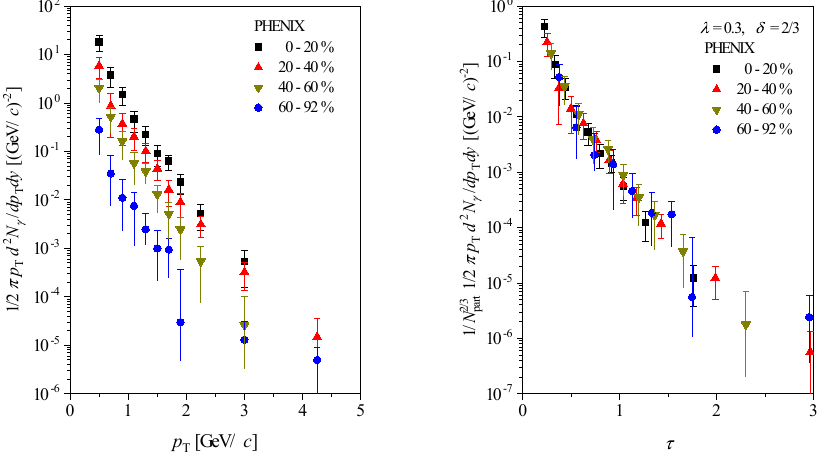
Figure 5. Illustration of N part geometrical scaling of the (cid:13) yields in heavy ion collisions for di (cid:11) erent centrality classes for PHENIX AuAu data at 200 GeV [20]. Left panel: transverse momentum spectra of direct photons at four centrality classes: 0-20% (black squares), 20-40% (red up-triangle) 40-80% (dark green down-triangles), 6–92% (blue circles). Right panel: scaled spectra for (cid:14) = 2 = 3. Lower error bars without end caps have been arbitrarily shortened for better